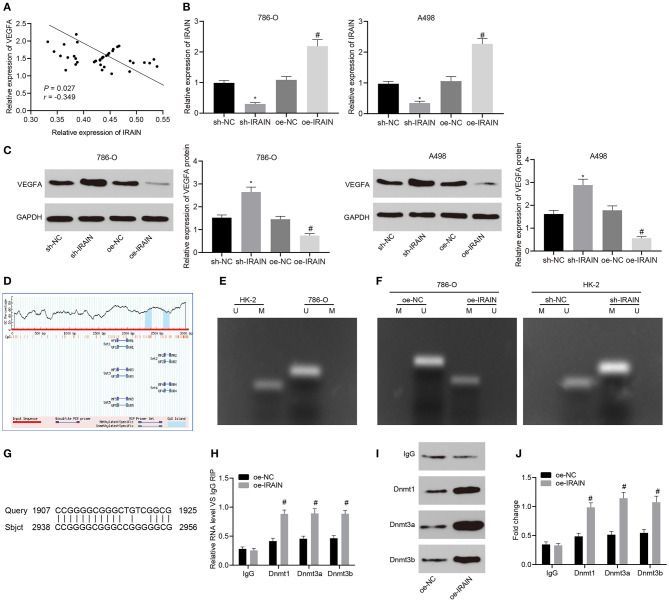
Upregulation of lncRNA IRAIN downregulates VEGFA via recruitment of DNA methylase to the promoter region of VEGFA. (A) The correlation analysis of the expression between lncRNA IRAIN and VEGFA. (B) The expression of lncRNA IRAIN in 786-O and A498 cells after alteration of lncRNA IRAIN measured by RT-qPCR normalized to GAPDH. (C) The expression of VEGFA in 786-O and A498 cells after alteration of lncRNA IRAIN measured by Western blot analysis normalized to GAPDH. (D) CpG islands in the VEGFA promoter region predicted on MethPrimer (http://www.urogene.org/cgi-bin/methprimer/methprimer.cgi). (E) Methylation status at specific sites in HK-2 and 786-O cells detected by MSP. (F) Methylation status at specific sites in HK-2 and 786-O cells in response to oe-IRAIN detected by MSP. (G) Binding form between the lncRNA IRAIN and VEGFA promoter regions examined by a Blast online alignment. (H) The binding of lncRNA IRAIN and methyltransferase assessed by RIP assay. (I) The binding of lncRNA IRAIN and methyltransferase assessed by RNA-protein pull down. (J) Methyltransferase enrichment in the VEGFA promoter region detected by ChIP assay. *p < 0.05 cells transfected with sh-IRAIN vs. cells transfected with sh-NC. #p < 0.05 cells transfected with oe-IRAIN vs. cells transfected with oe-NC. Measurement data were expressed as mean ± standard deviation. Data between two groups were compared using unpaired t-test. The experiment was repeated independently 3 times.